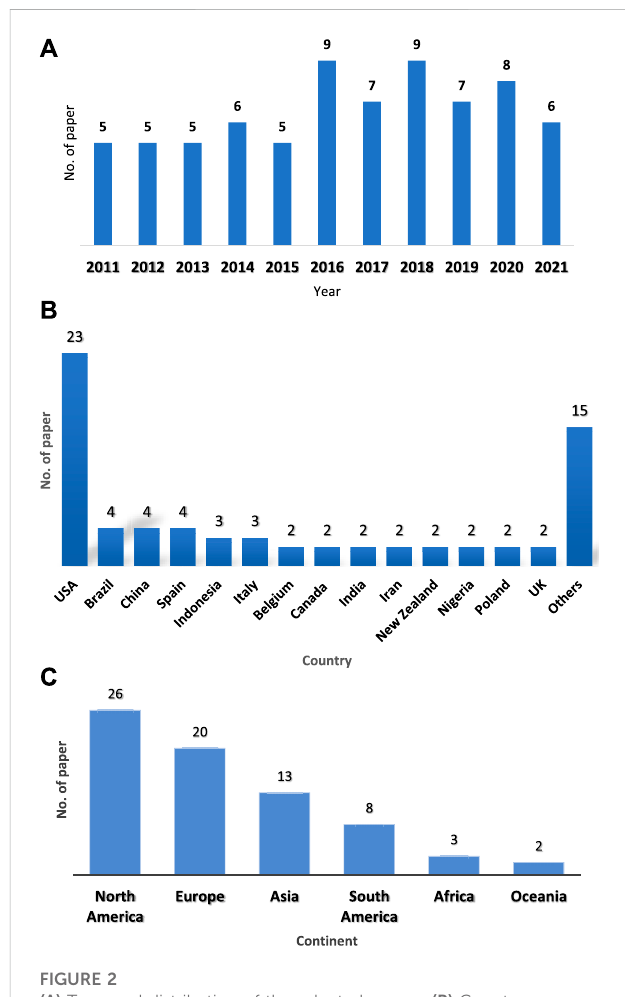
FIGURE 2 (A) Temporal distribution of the selected papers. (B) Country distribution of the selected papers. (C) Continent distribution of the selected